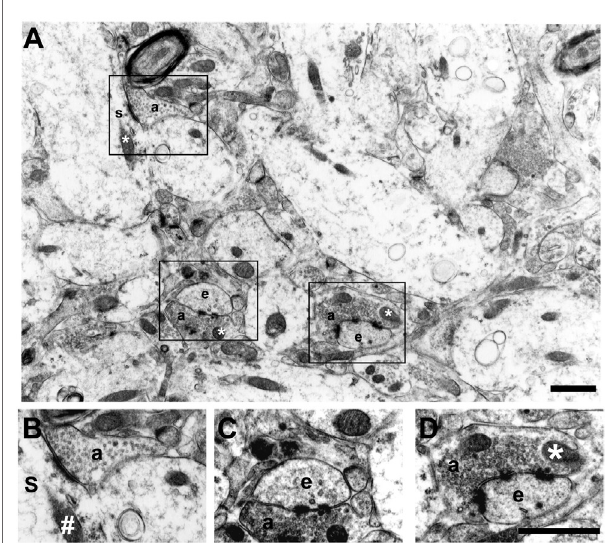
FigUre 1 | electron micrograph of the inner molecular layer showing asymmetric synaptic profiles and their localization in dendritic spines or shafts (a) . (B–D) are higher magnification views of different synaptic contacts: PSD1 [ (B) – non-perforated type 1, synaptic profiles with a single-synaptic bouton]; PSD2 [ (c) – perforated type 2, synaptic profiles with two postsynaptic densities]; and PSD3 [ (D) – perforated type 3, synaptic profiles with more than two postsynaptic densities]. Note the spherical presynaptic vesicles and mitochondrion (*) in the axon terminal (a) contacting a dendritic spine (e) and a dendritic shaft (s) with a mitochondria ( # ). Scale bars, 1.25 μ